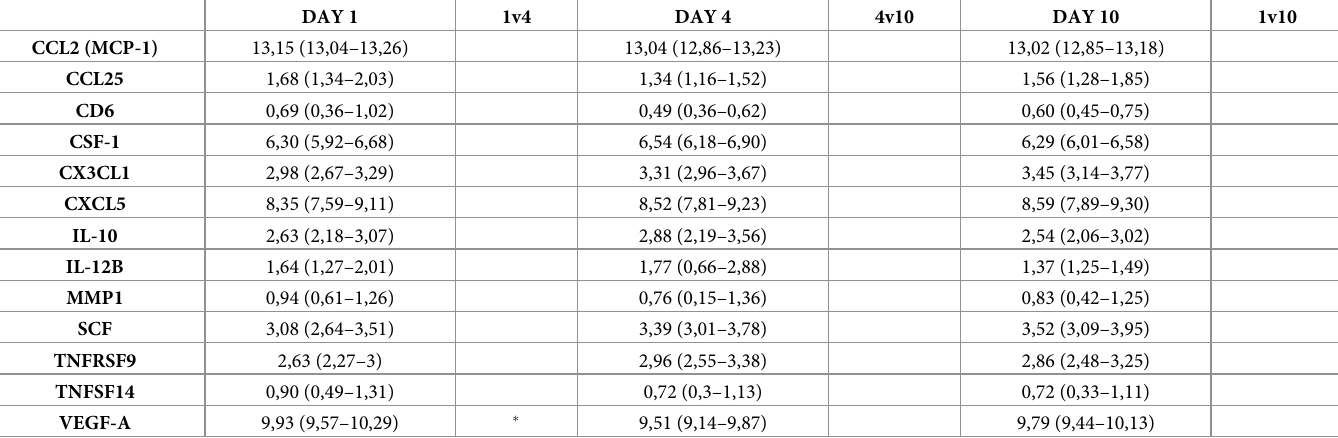
Table 6. Group D